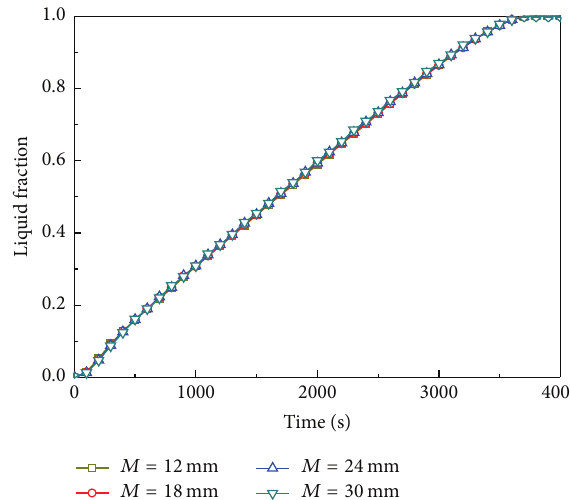
Figure 8: Time variation of the liquid fraction at various zigzag lengths.